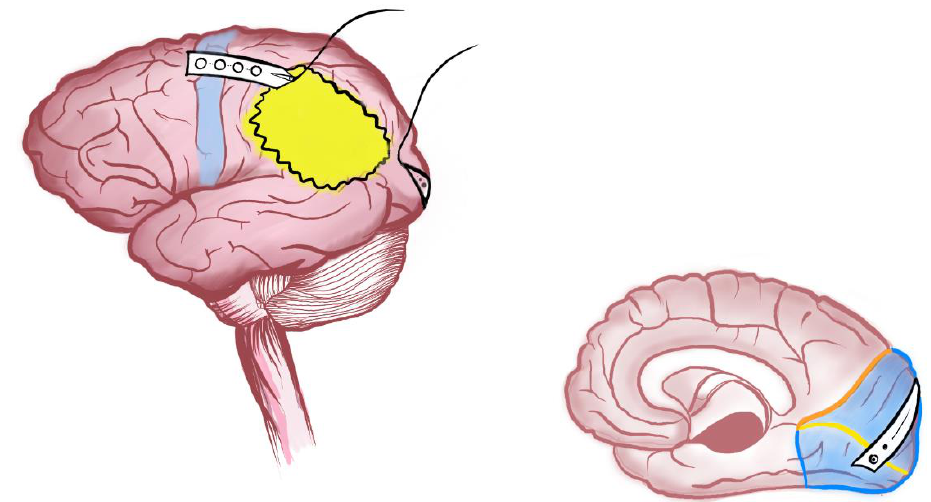
Figure 4. Illustration of Dual Strip technique with strip placed over the motor cortex ( Blue ) (for continuous mapping of CST) and occipital cortex (continuous mapping of VEPs) in the patient with parietal tumour ( Yellow ).